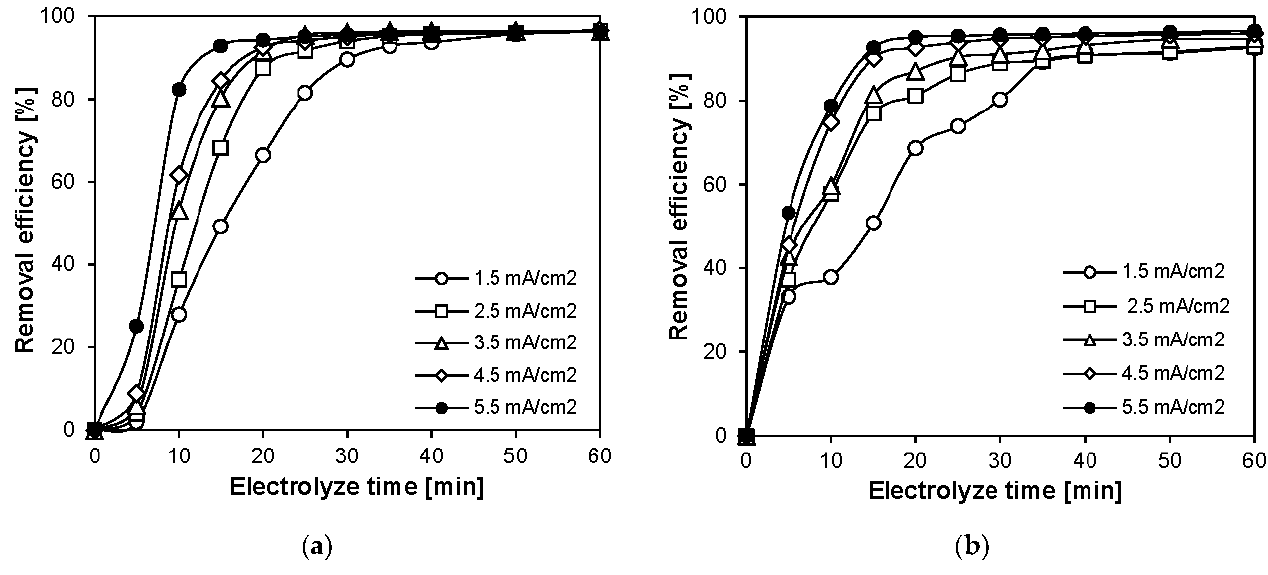
Figure 4. Effect of current density on removal efficiency of ( a ) turbidity and ( b ) color.